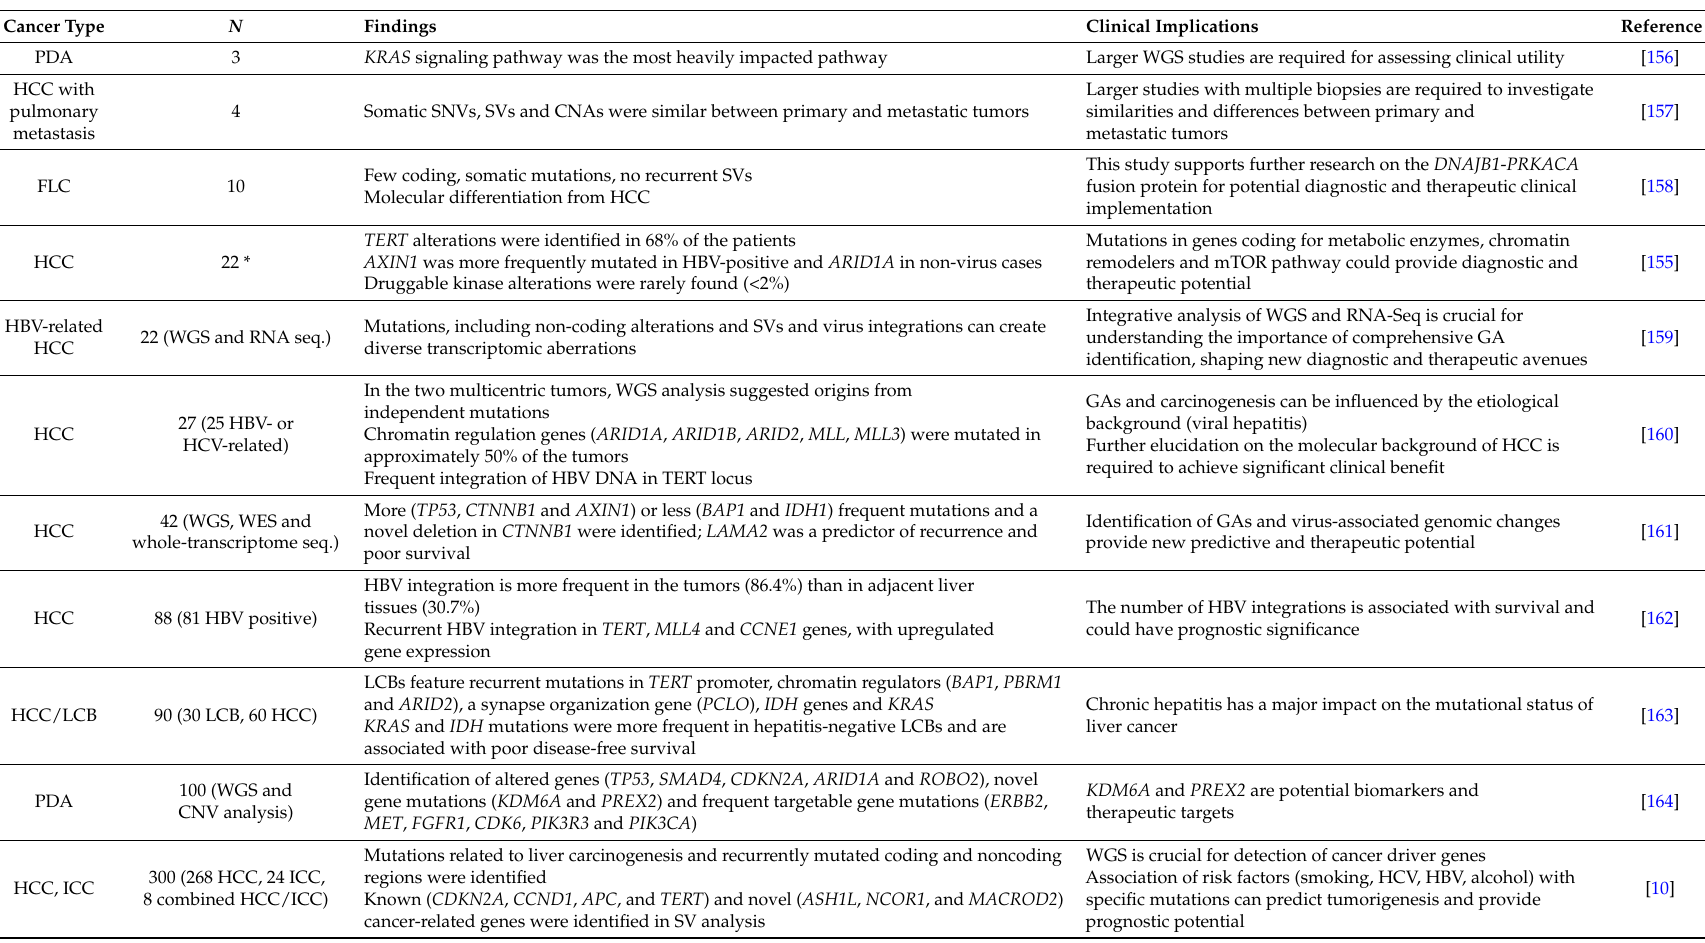
Table 9. Whole-genome sequencing studies on hepatobiliary and pancreatic